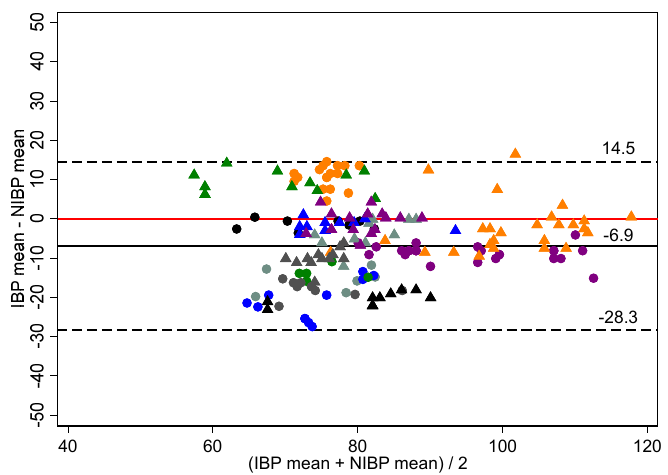
Figure 2. Bland–Altman plot of agreement for 177 paired mean arterial blood pressure measurements (mm Hg) made non-invasively compared to those made invasively using the Bionet BM7Vet in 14 healthy, anaesthetised horses. The non-invasive arterial blood pressure cuff was placed at the proximal tail base. Repeated observations from the same horse are plotted using the same colour- shape combination. The solid black line indicates mean bias, and the dashed lines indicate lower and upper limits of agreement. The solid red line represents zero bias. IBP invasive blood pressure, NIBP non-invasive blood pressure. Bias defines accuracy.